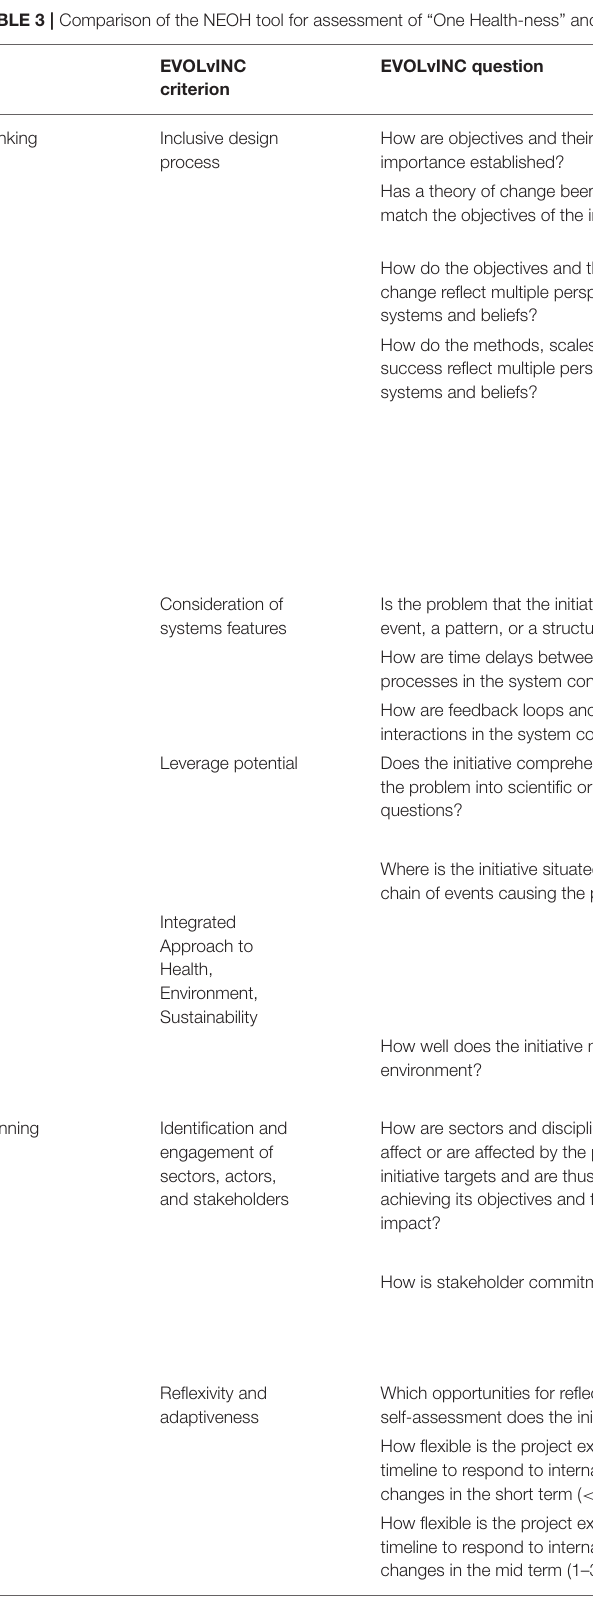
TABLE 3 | Comparison of the NEOH tool for assessment of “One Health-ness” and the EVOLvINC